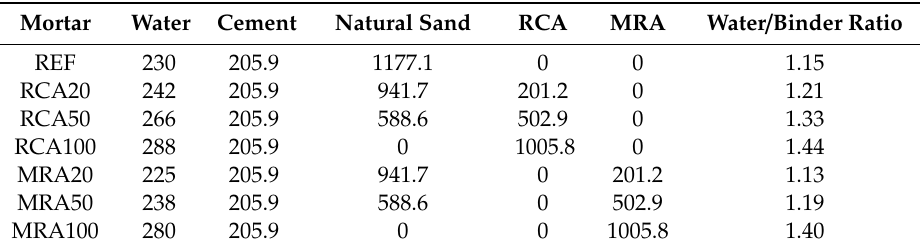
Table 4. Composition of the mortar’s mixes (kg/m 3 ).